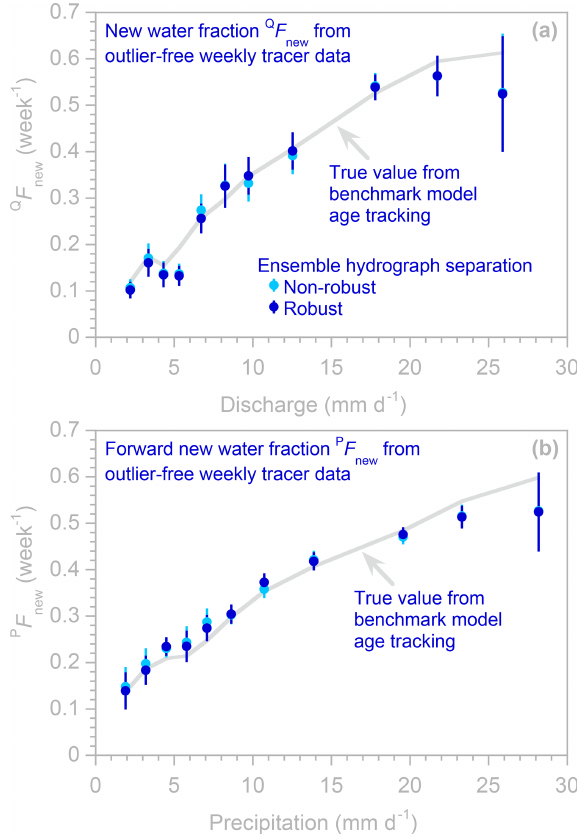
Figure 10. Profiles of new water fractions ( Q F new , panel a ) and for- ward new water fractions ( P F new , panel b ), estimated using robust and non-robust methods (dark and light blue symbols, respectively; error bars indicate 1 standard error) applied to weekly tracer time series from the benchmark model using parameters that generate a humped distribution (see Fig. 6). Some light blue symbols are in- visible where they are overprinted by dark blue symbols. The light gray lines show the true new water fractions, as calculated from wa- ter age tracking in the benchmark model. In contrast to the results from the daily time series (Fig. 9), the weekly tracer time series yield new water fraction profiles that are consistent with the true values determined by age